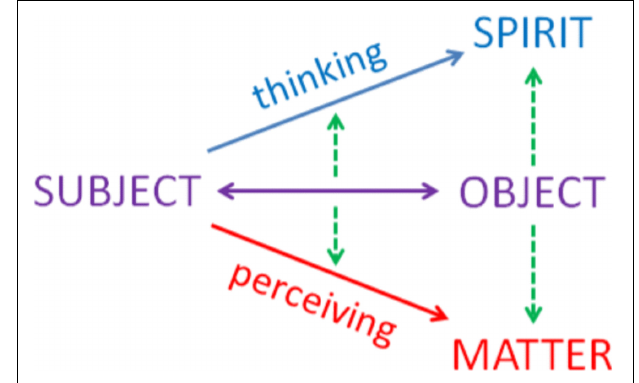
FIGURE 1 | Differentiation processes in the history of consciousness. The basic process is the increasing separation of subject (human being) and object (world). Closely interwoven with this is the differentiation of the cognition object into a spiritual aspect and a material aspect and the successive realization of equivalent forms of knowing–thinking and